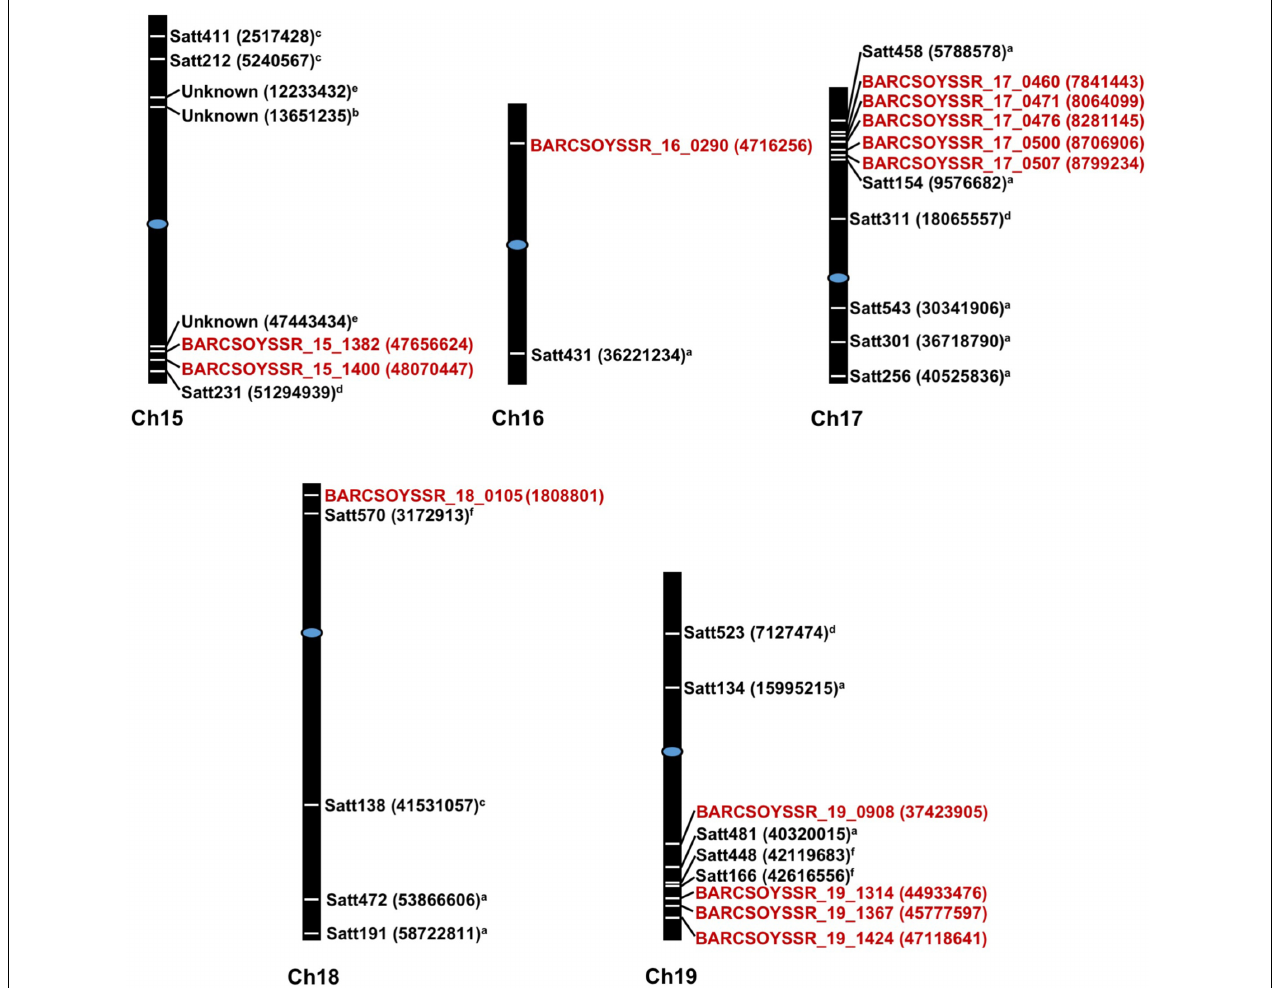
FIGURE 2 | Physical starting positions of markers associated with disease resistance in previous studies and this study. Chromosome numbers are displayed under each chromosome. Markers locations are indicated by white lines placed directly on chromosomes and are placed relative to physical positions. Physical starting position of the microsatellite markers are shown in parenthesis. Markers in red text are from the present study while markers from previous study are shown in black text. Centromeres are indicated by blue ovals. a Arahana et al., 2001; b Bastien et al., 2014; c Guo et al., 2008; d Han et al., 2008; e Iquira et al., 2015; f Sebastian et al.,